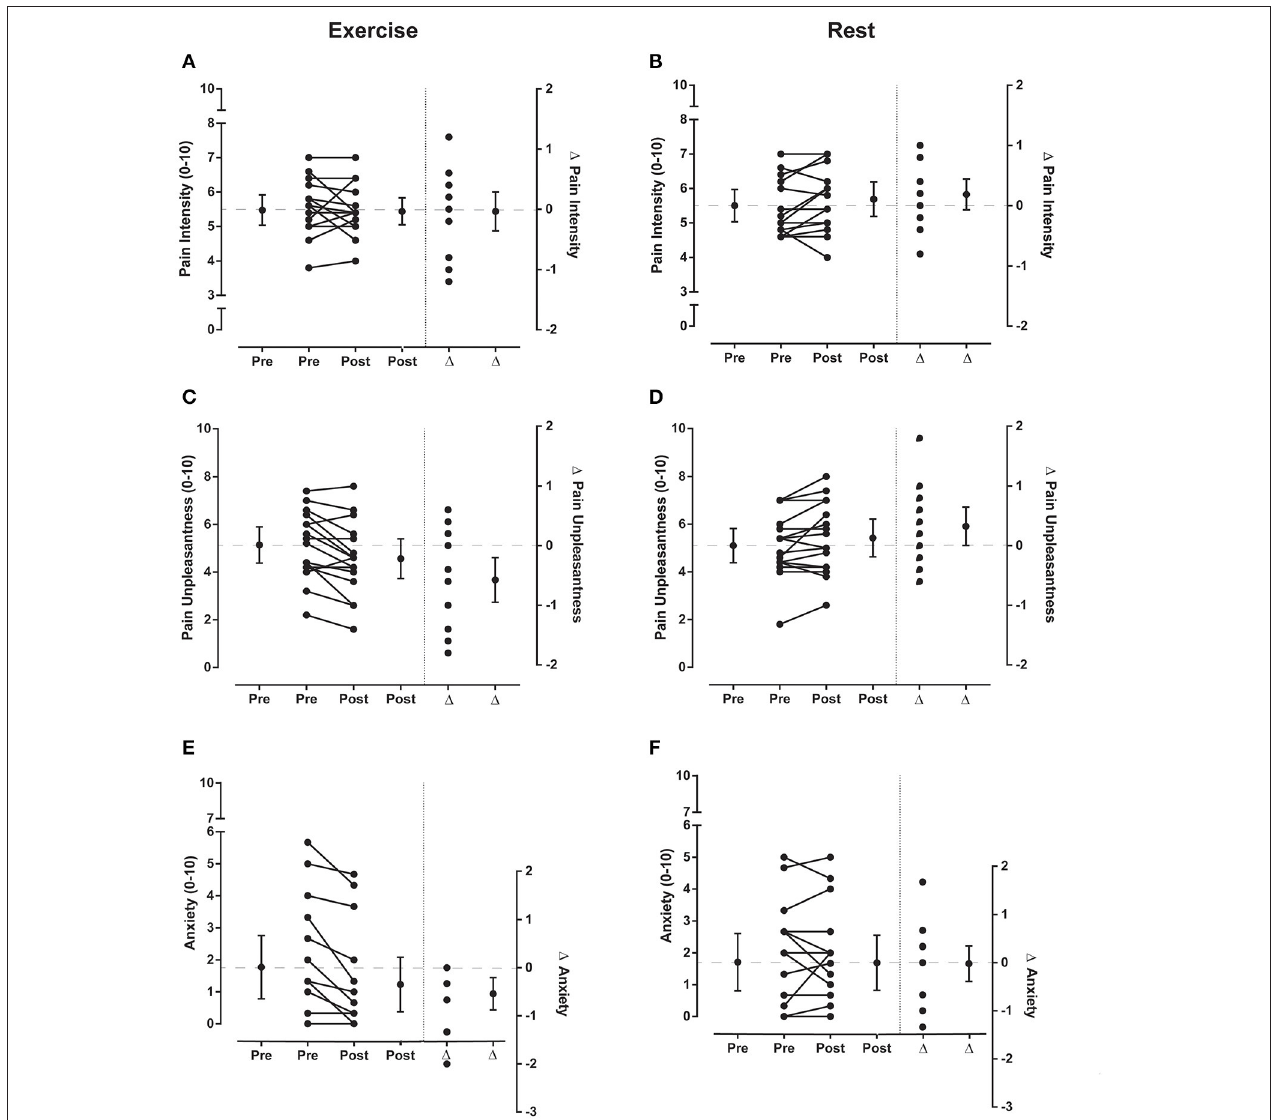
FIGURE 5 | Pain ratings for electrical stimuli Experiment 1 . Individual and group data (mean and 95% confidence interval) for ratings of pain intensity, pain unpleasantness and anxiety (left side of vertical dotted lines in each graph) before (pre) and after (post) exercise (left panels) or rest (right panels) during Experiment 1 . Five ratings were averaged to give a single value for ratings of pain intensity and pain unpleasantness for the sets of electrical stimuli and 3 ratings were averaged to give a single value for anxiety. Individual and group differences ( 1 ; mean and 95% confidence interval) in ratings from pre to post exercise or rest are shown to the right side of the vertical dotted line in each graph. In each of these plots the zero-difference level on the right-hand y-axis is aligned to the group mean for the pre-exercise reference condition. Data to the left of the vertical dotted line are plotted against the left-hand y-axis and data to the right of the vertical dotted line are plotted against the right-hand